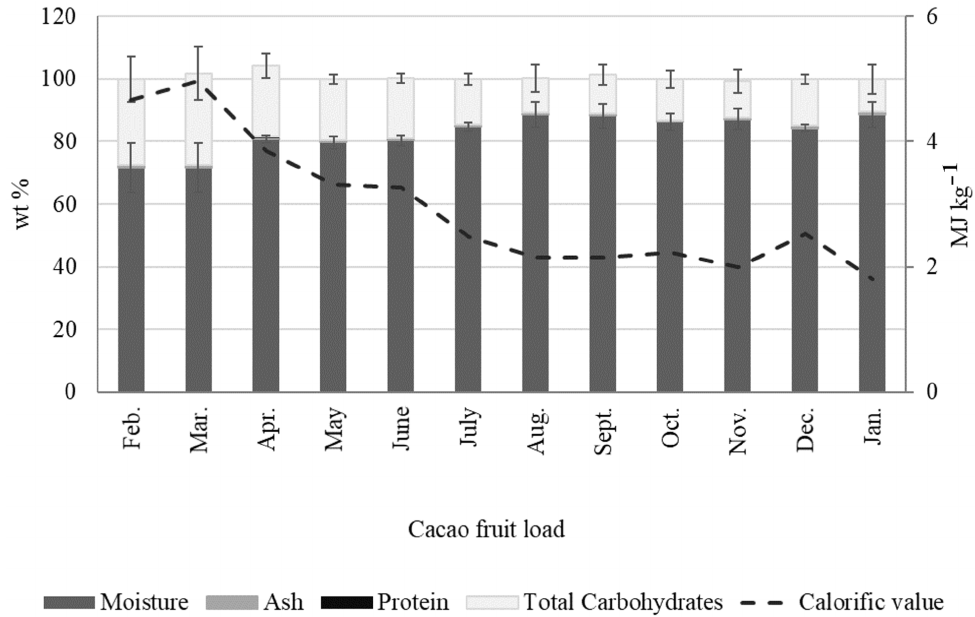
Figure 9. Seasonal variations in the proximate analysis of CME from Colombian CCN51 cacao fruit. CME’s high sugar content hints at a valuable biomass output, with potential uses as human food or as a carbon source in industrial processes. The average sugar values in CME from CCN51 cacao fruit correspond to 75.54 ± 9.54 g L − 1 for fructose, 67.15 ± 8.36 g L − 1 for glucose, and 14.08 ± 8.89 g L − 1 for saccharose. The glucose and fructose contents are higher than the values of 45.8 ± 1.2 g L − 1 and 32.5 ± 0.3 g L − 1 [72]; however, the